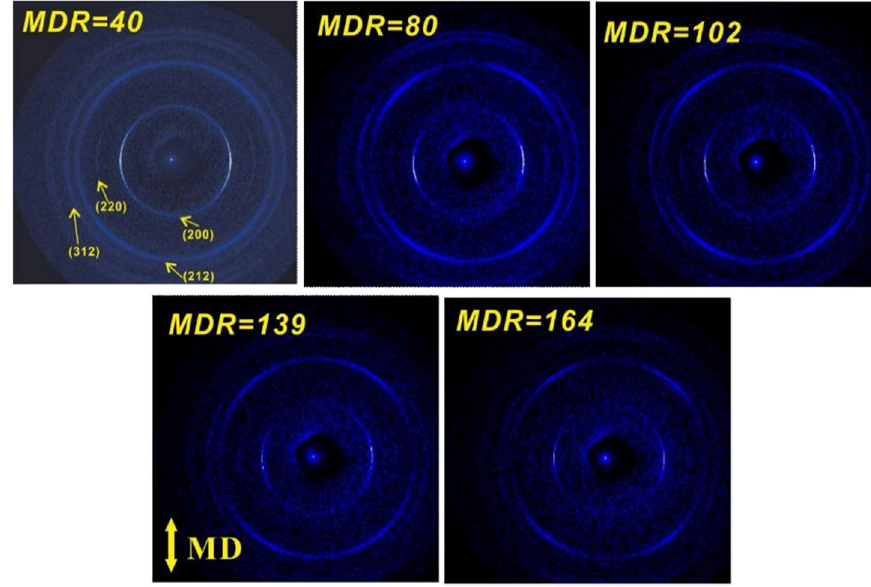
Figure 3: WAXS - scattering patterns of PMP fi lms prepared at di ff erent